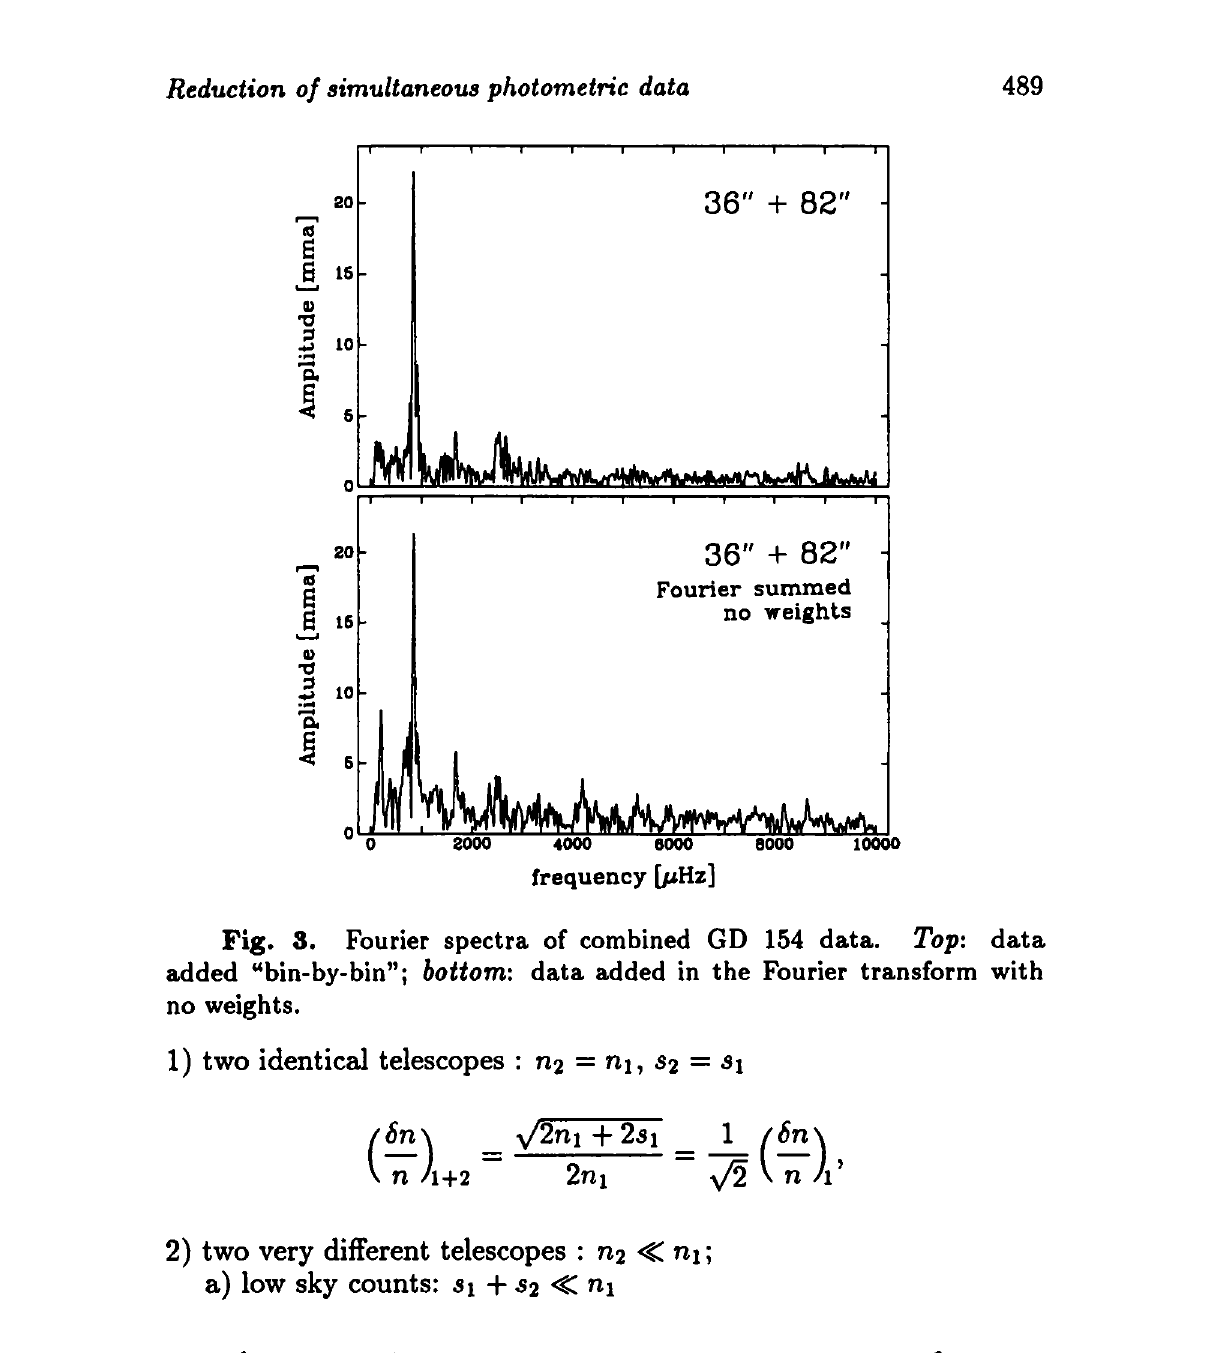
Fig. 3. Fourier spectra of combined GD 154 data. Top : data added w bin-by-bin"; bottom : data added in the Fourier transform with no